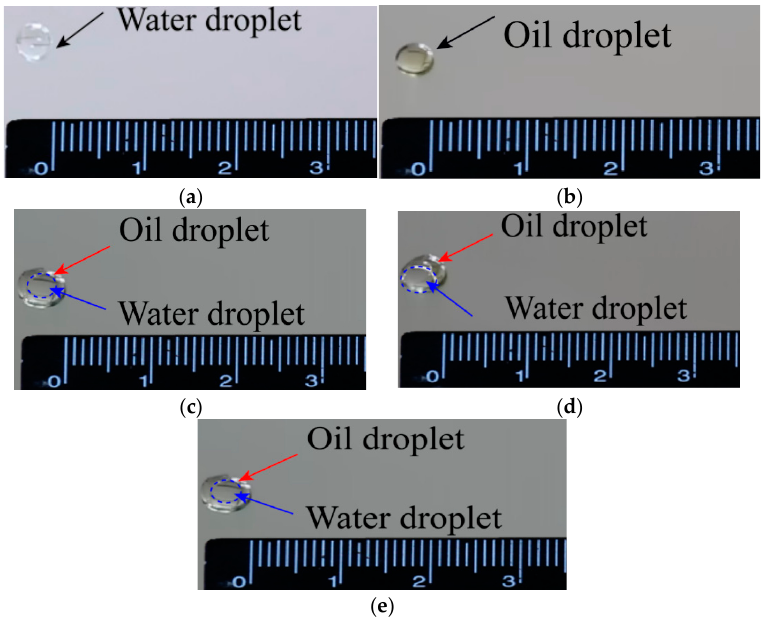
Figure 3. ( a ) The water drop on the inclined mirror plate. ( b ) The oil drop on the inclined mirror plate. ( c ) The water droplet on the top of the oil droplet on the inclined mirror plate. ( d ) Oil droplets are placed on the water. ( e ) The oil and water drops are placed on the inclined mirror plate side by side. Reproduced from Ref. [96].